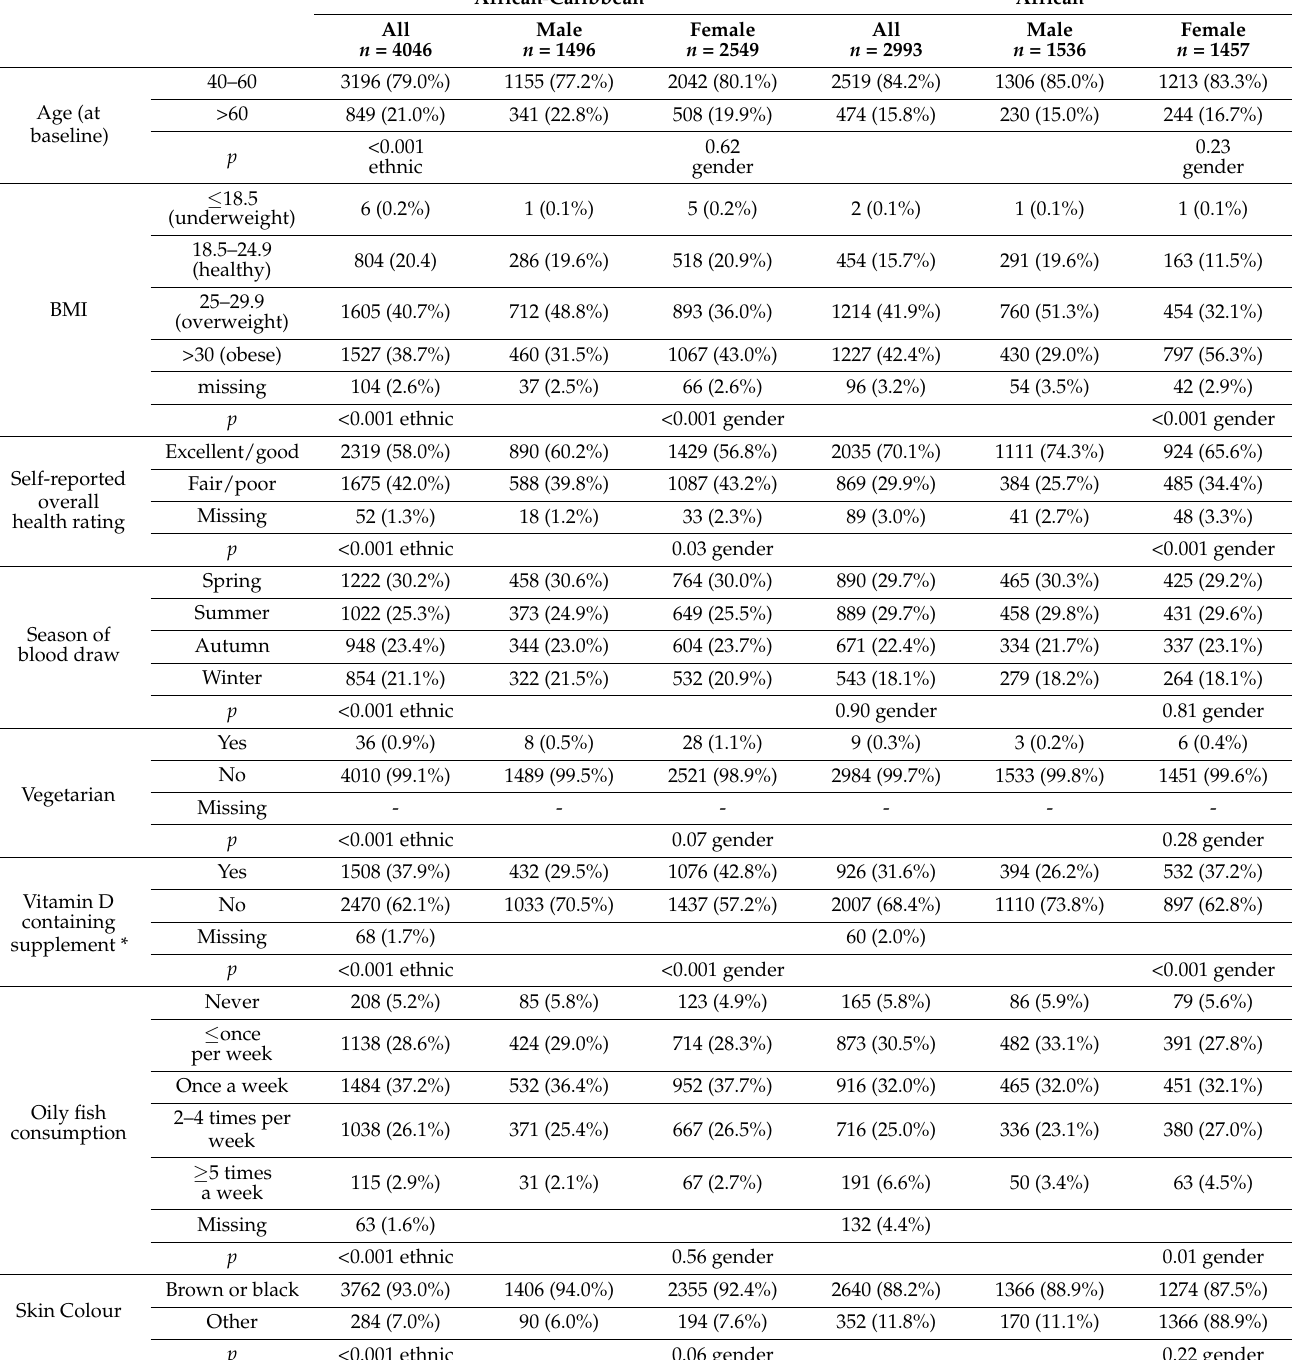
Table 1. Categorical demographic and behavioural variables for the African-Caribbean ( n = 4046) and African ( n = 2993) UK Biobank participants who had a valid 25(OH)D measurement, including those under the detection limit †